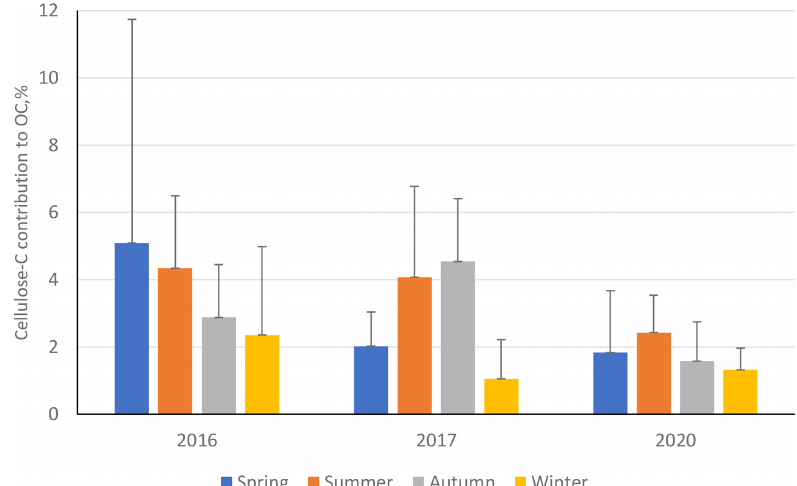
Figure 9. Percentage contribution of cellulose carbon towards overall organic carbon (cellulose C to OC) at ANDRA-OPE during the three separate sampling periods: 2016, 2017, and 2020. Black error bars represent 1 standard deviation of the seasonal means. Only positive error bars are shown to aid clarity. Seasons are defined as December–February (winter), March–May (spring), June–August (summer), and September–November